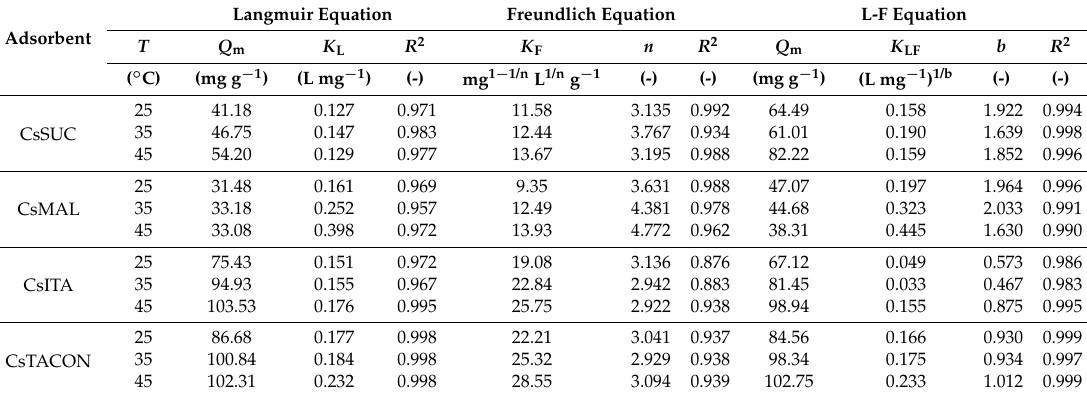
Table 2. Equilibrium parameters for DCF adsorption from aqueous media onto chitosan derivatives at 25, 35, 45 ◦ C (fitting to Langmuir, Freundlich and L-F equations). Langmuir Equation Freundlich Adsorbent